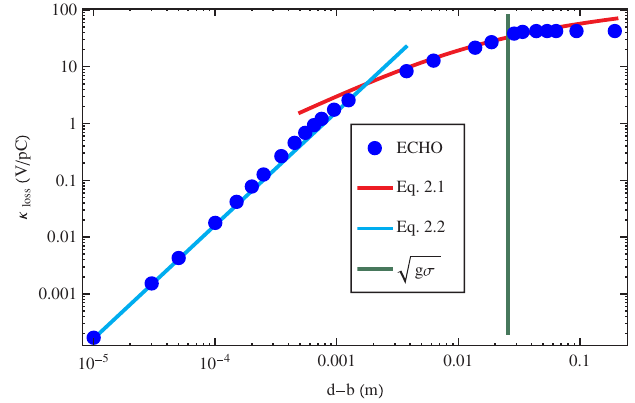
FIG. 3. (Color) For a pillbox cavity in the step regime, the dependence of the loss factor on d (cid:2) b is shown for (cid:1) ¼ 0 : 5 mm , b ¼ 6 : 25 mm , and g ¼ 2000 mm . The dots represent the results of calculations using the ECHO code. The red curve is given by Eq. (2.1) and the aqua curve by Eq. (2.2). The vertical ffiffiffiffiffiffiffi p g(cid:1) green line is d ¼ . To the left of this line lies the step regime and to its right the cavity